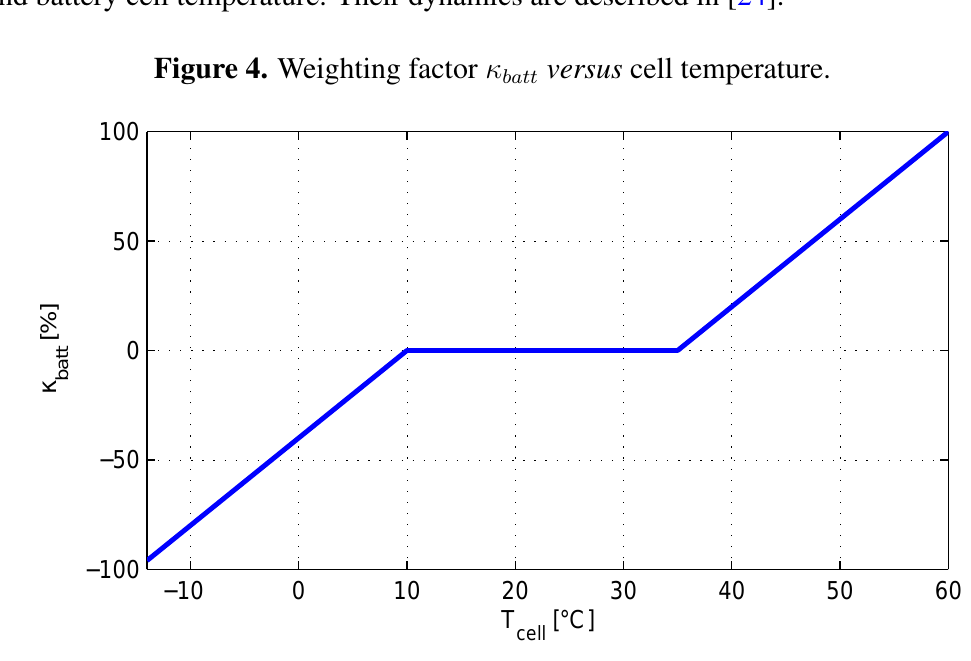
Figure 4. Weighting factor κ